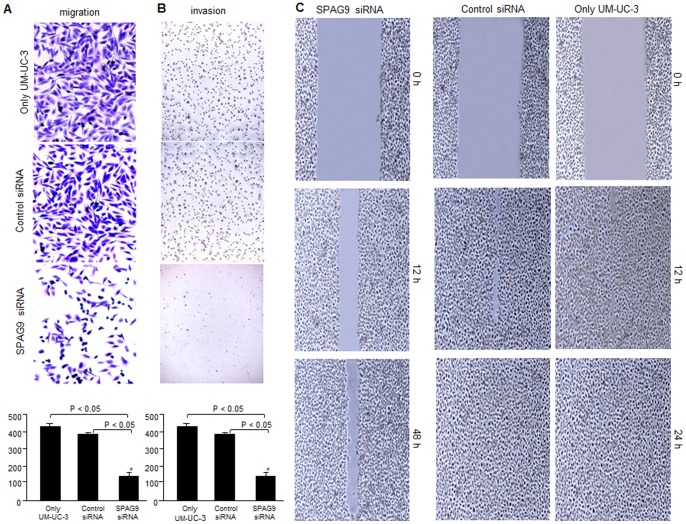
Effect of SPAG9 expression on migration and invasion ability of UM-UC-3 cells.Knockdown of SPAG9 expression inhibited (A) Migration, (B) Invasion and (C) Wound healing assay are depicted in only cells scrambled siRNA and SPAG9 siRNA transfected cells.